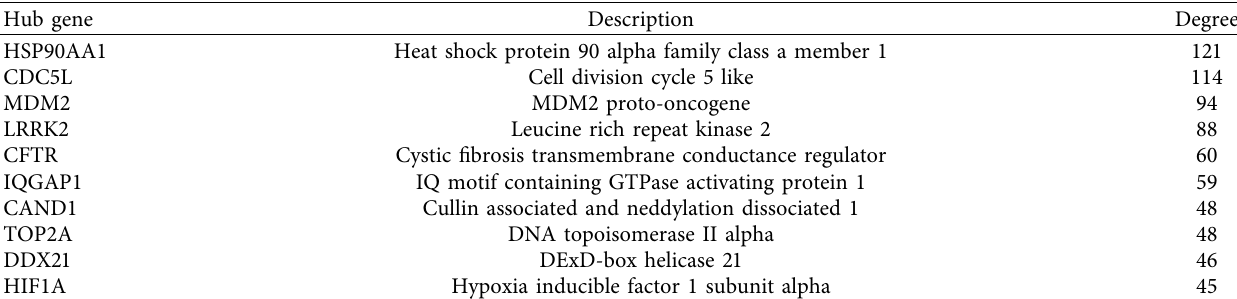
Figure 4: Significant pathway enrichment of DEGs and PPI network analyses of DEGs in lung tissues of PAH patients. (a) Significant pathway enrichment of DEGs, blue represents the signaling pathway, green represents downregulated genes, and red represents upregulated genes. (b) PPI network analyses of DEGs in lung tissues of PAH patients. DEGs are shown in orange. Most significant hub genes according to the highest number of connections, are arranged in the outermost circle. Table 3: Top 10 hub